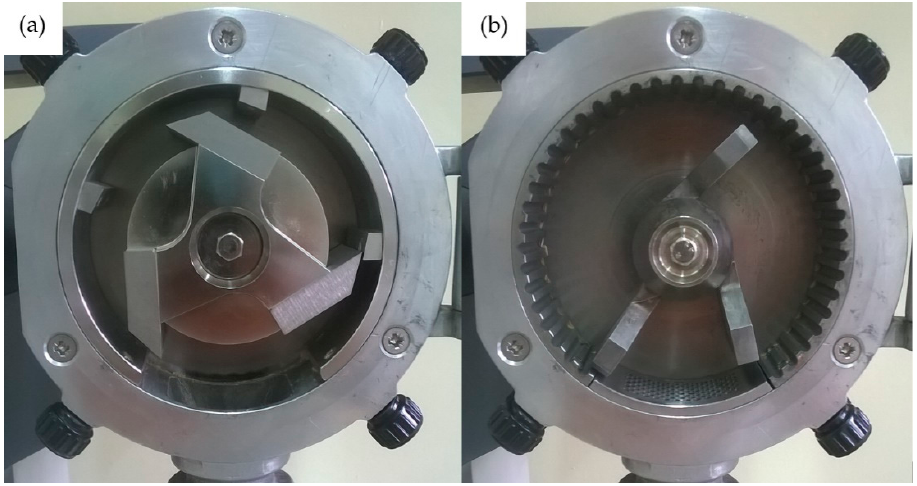
Figure 2. Mill PX-MFC 90D Polymix equipped with a knife ( a ) and hammer ( b ) grinding system.